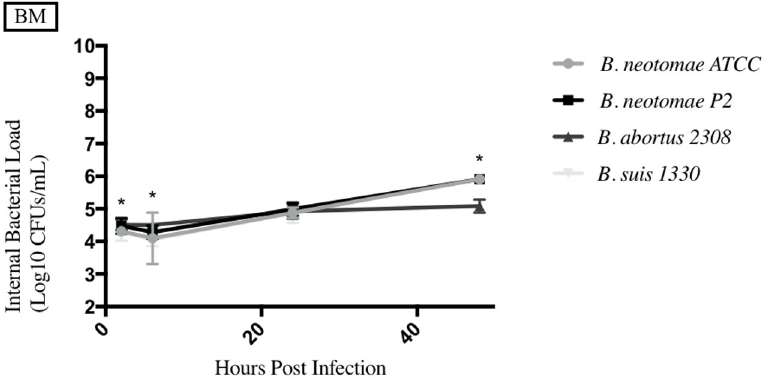
Fig 7. Intracellular survival of Brucella species in the bovine macrophage cell line (BM). Intracellular Brucella spp. CFUs were determined over 48hrs in BM as described. Error bars represent the standard deviation of the triplicates from a single experiment. � represents when intracellular CFUs from more than one species tested statistically differs from BN with any p value lower than 0.05.